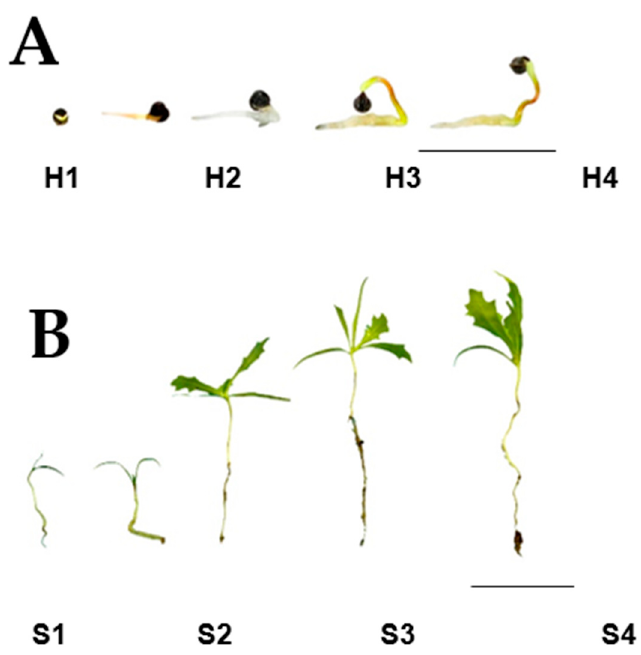
Figure 2. Aspects of A. mexicana hypocotyls ( A ) and seedlings ( B ). The scale bars represent 1 cm in each case.